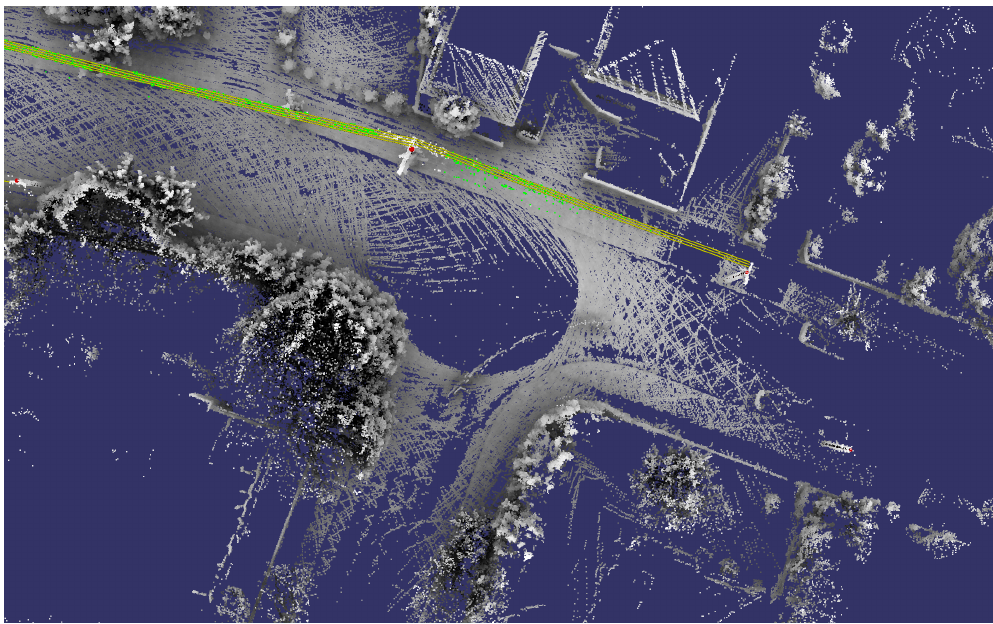
Figure 10. Example of a poorly observed span which caused a primary conductor to be rejected because it did not contain points along the entire span. Clustered conductor points are rendered green and fitted models are